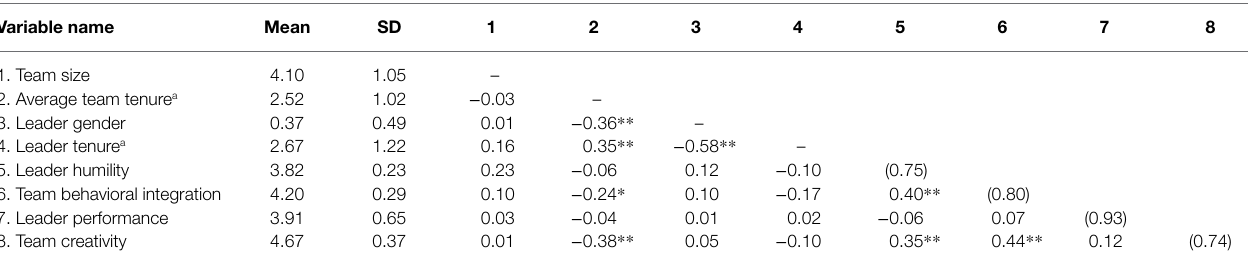
TABLE 1 | Descriptive statistics and correlations among study